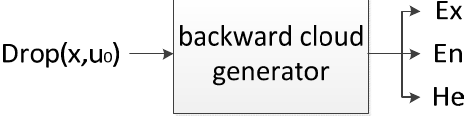
Figure 8. Flow chart of backward cloud generator.